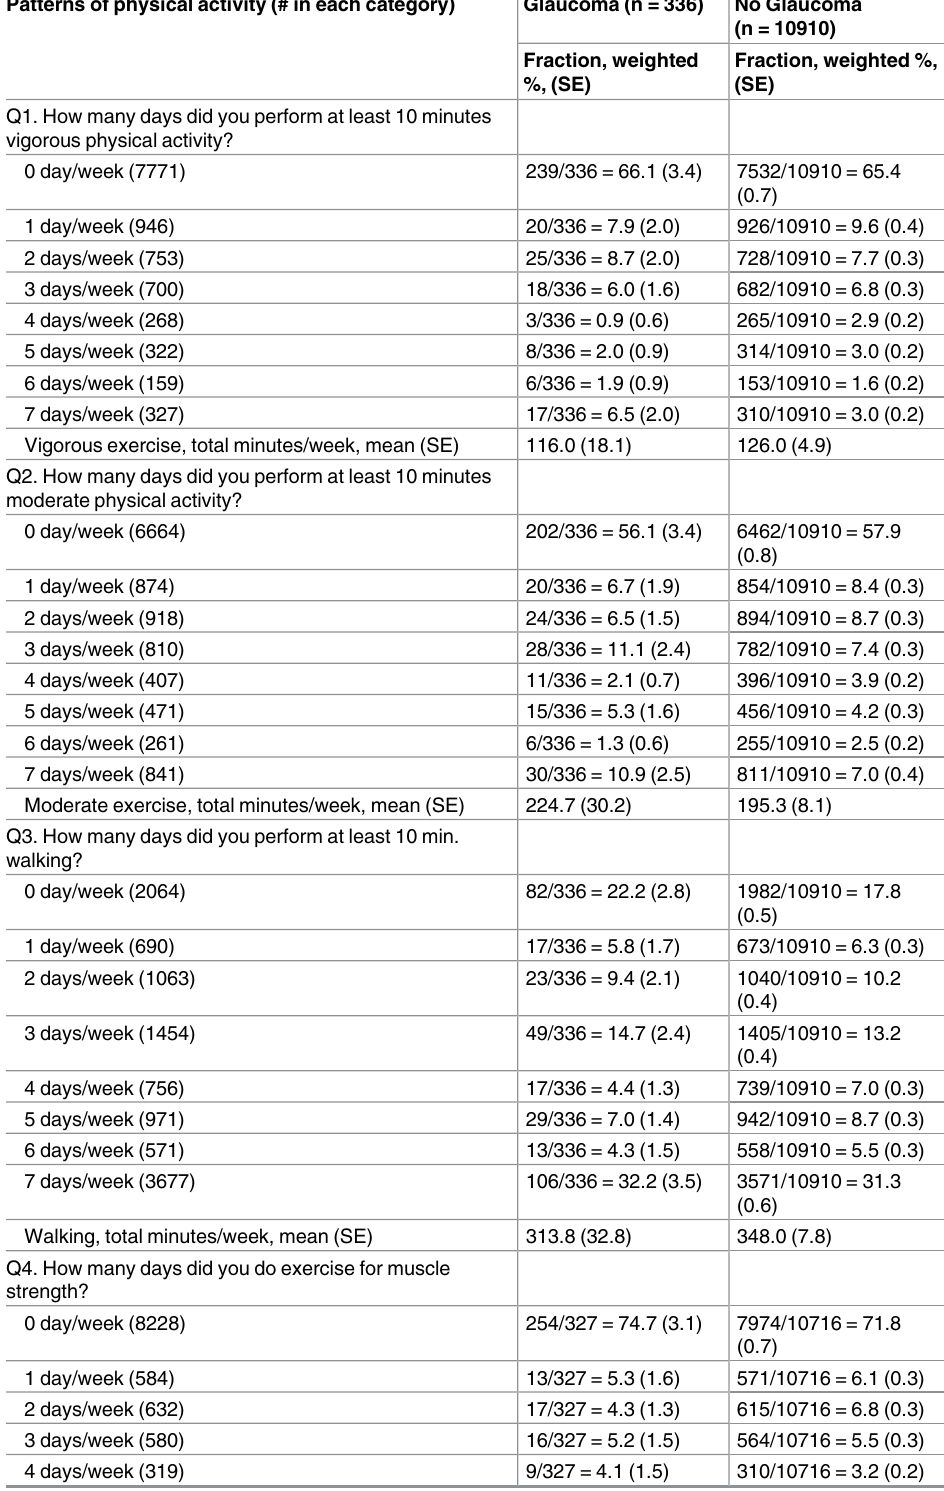
Table 2. Patterns of physical activity for patients with and without glaucoma. Patterns of physical activity (# in each